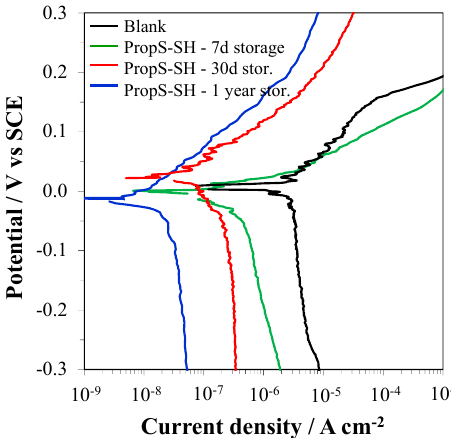
Figure 2. Polarization curves recorded after 7 days of immersion in AR × 10 at 30 °C, on bare bronze and 3-mercaptopropyl-trimethoxysilane (PropS-SH) coated bronze. The coatings were obtained after different storage times of the silane solution at 4 °C. Curing of 1 day at RT.